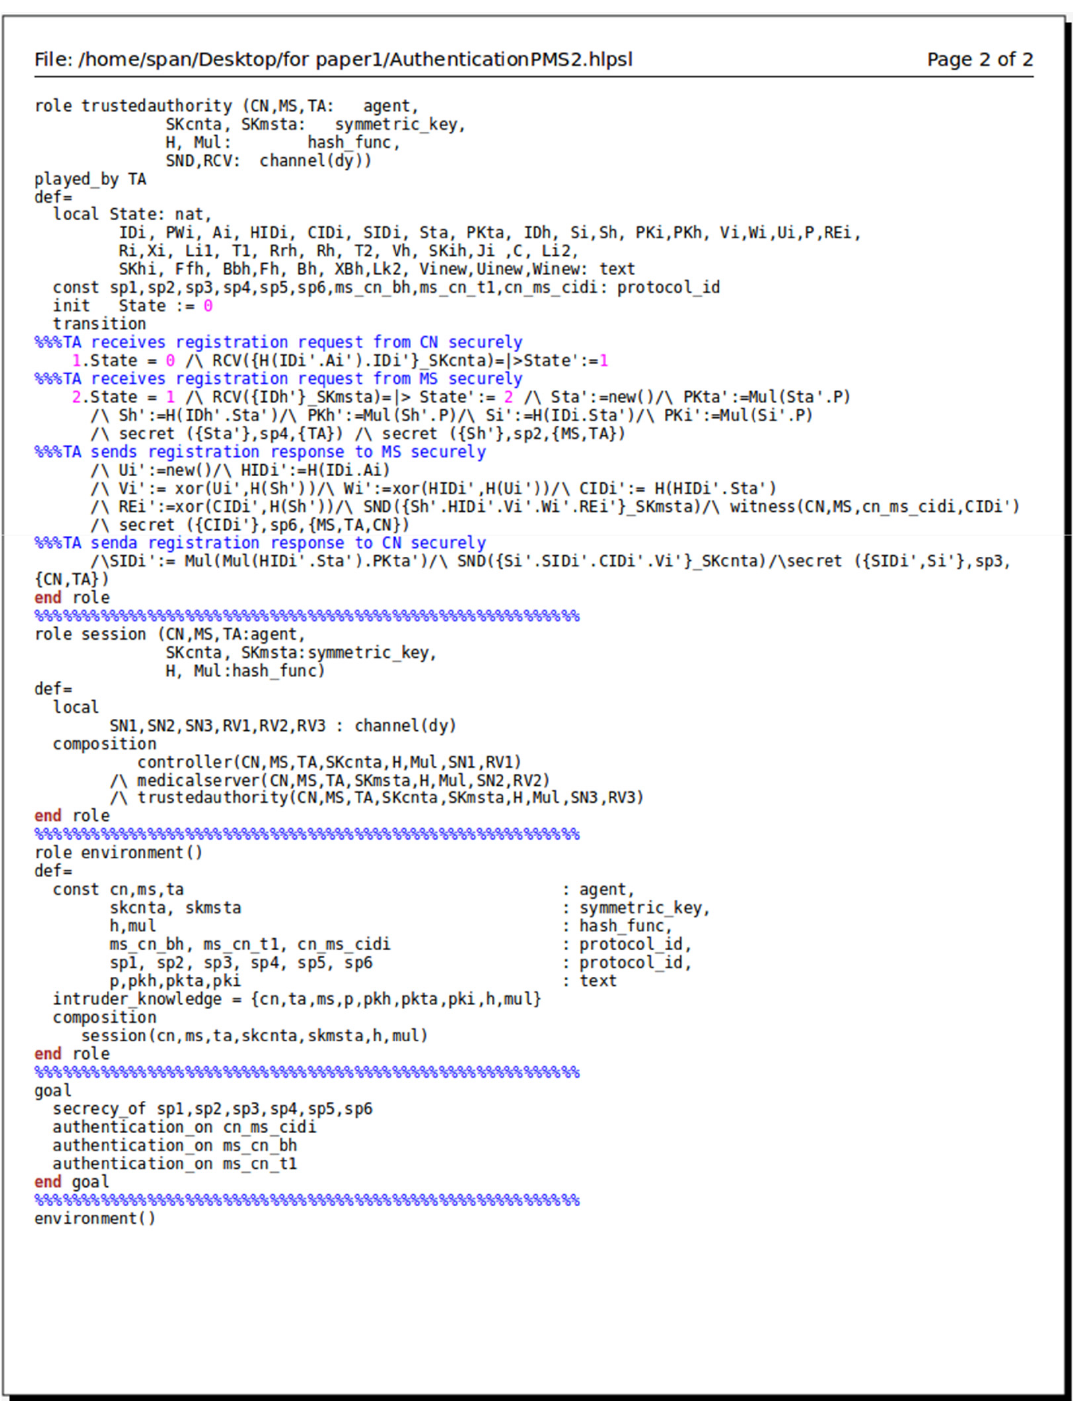
Figure 9. The HLPSL code of P-II.